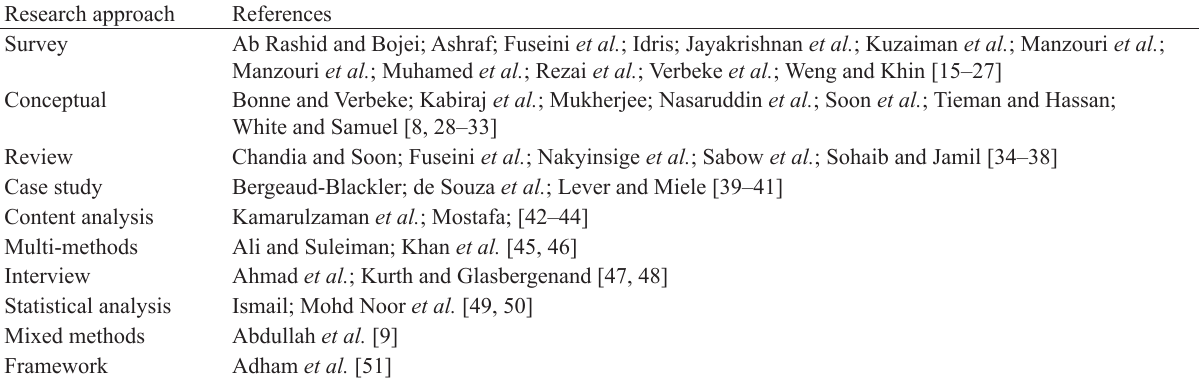
Table 1 Classification of publications according to research methodologies Research